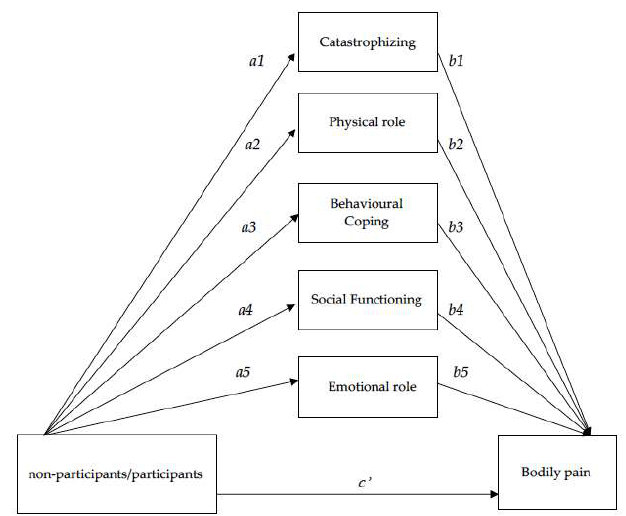
Figure 1. Hypothetical model of the relationship between non-participants / participants and bodily pain through catastrophizing, physical role, behavioural coping, social functioning and emotional role.